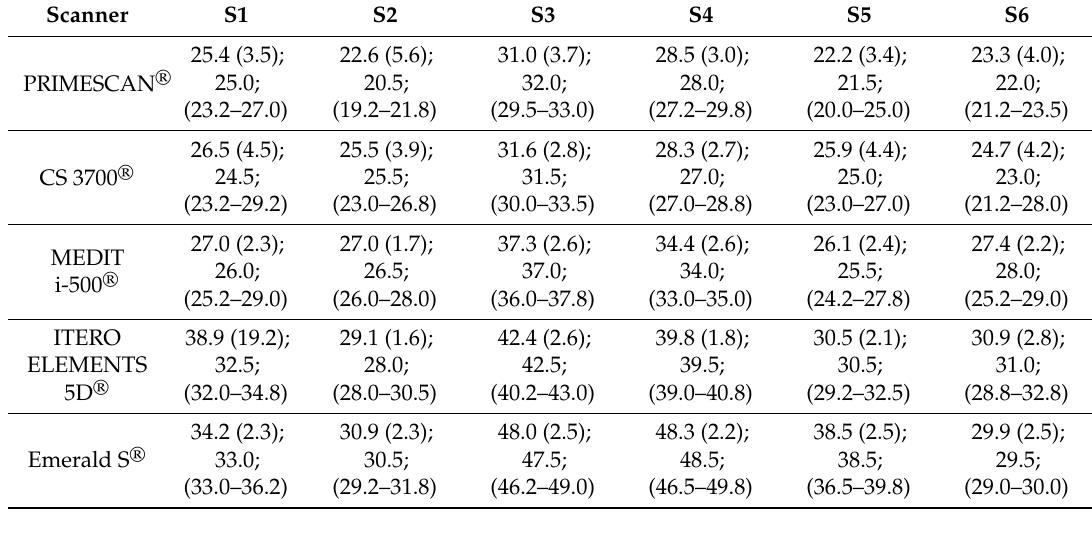
Table 2. Descriptive statistics: mean (SD); median; (Q1–Q3), in µ m.